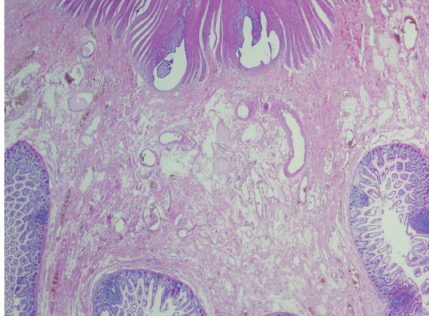
Figure 2: A nest of endometriotic glands and stroma lies in the muscularis propria of the ileum (HE, × 20).